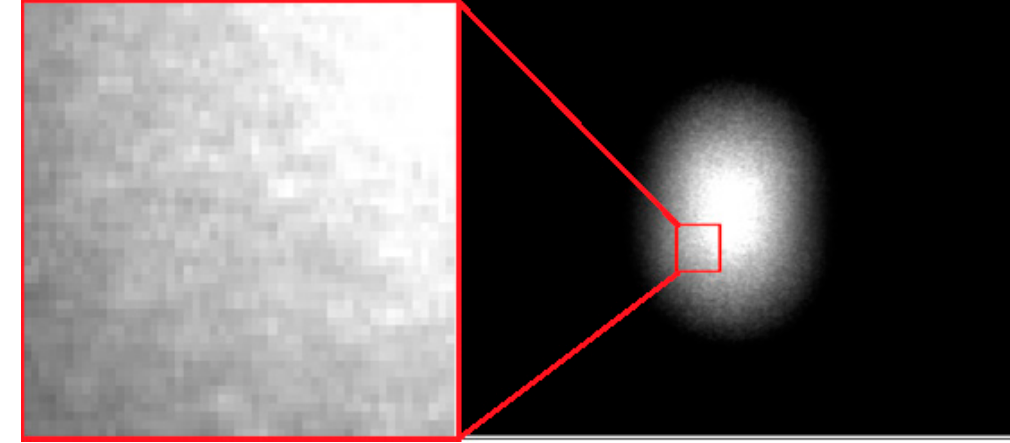
Figure 1. Template matching result example.